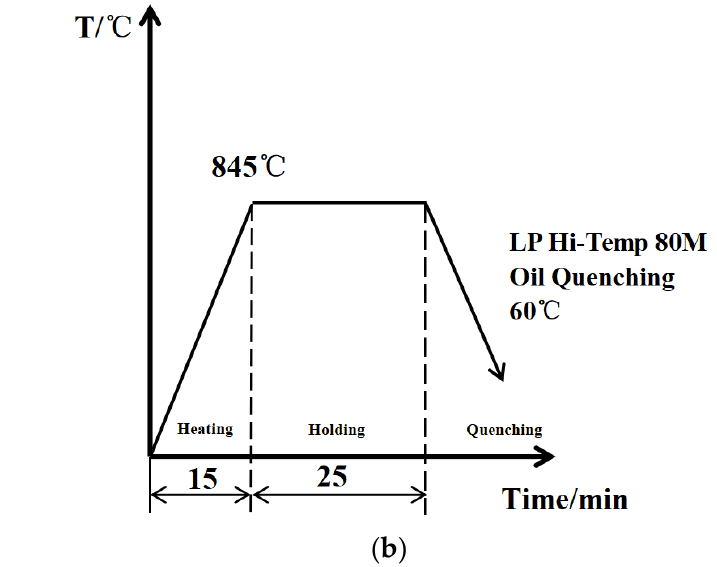
Figure 1. Part drawing of bearing outer ring and heat-treatment condition. ( a ) Part drawing of bearing outer ring; ( b ) heat-treatment process of GCr15.